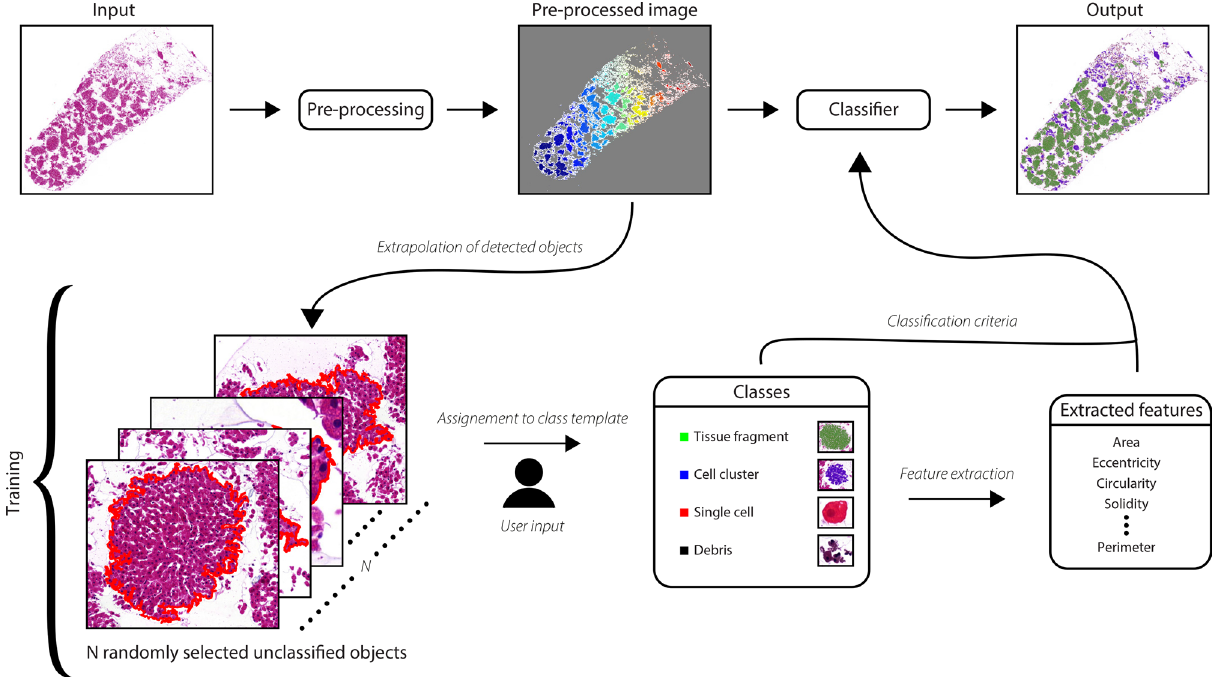
Figure 7. General description of the classification process. During the training phase a number N of randomly selected unclassified objects objects are selected from the data and firstly assigned to one of the output classes (tissue fragment, cell cluster, single cell, debris) by a user. Several morphological features (area, eccentricity, circularity, etc. ) are then extracted from such objects and used as classification criteria during the classification